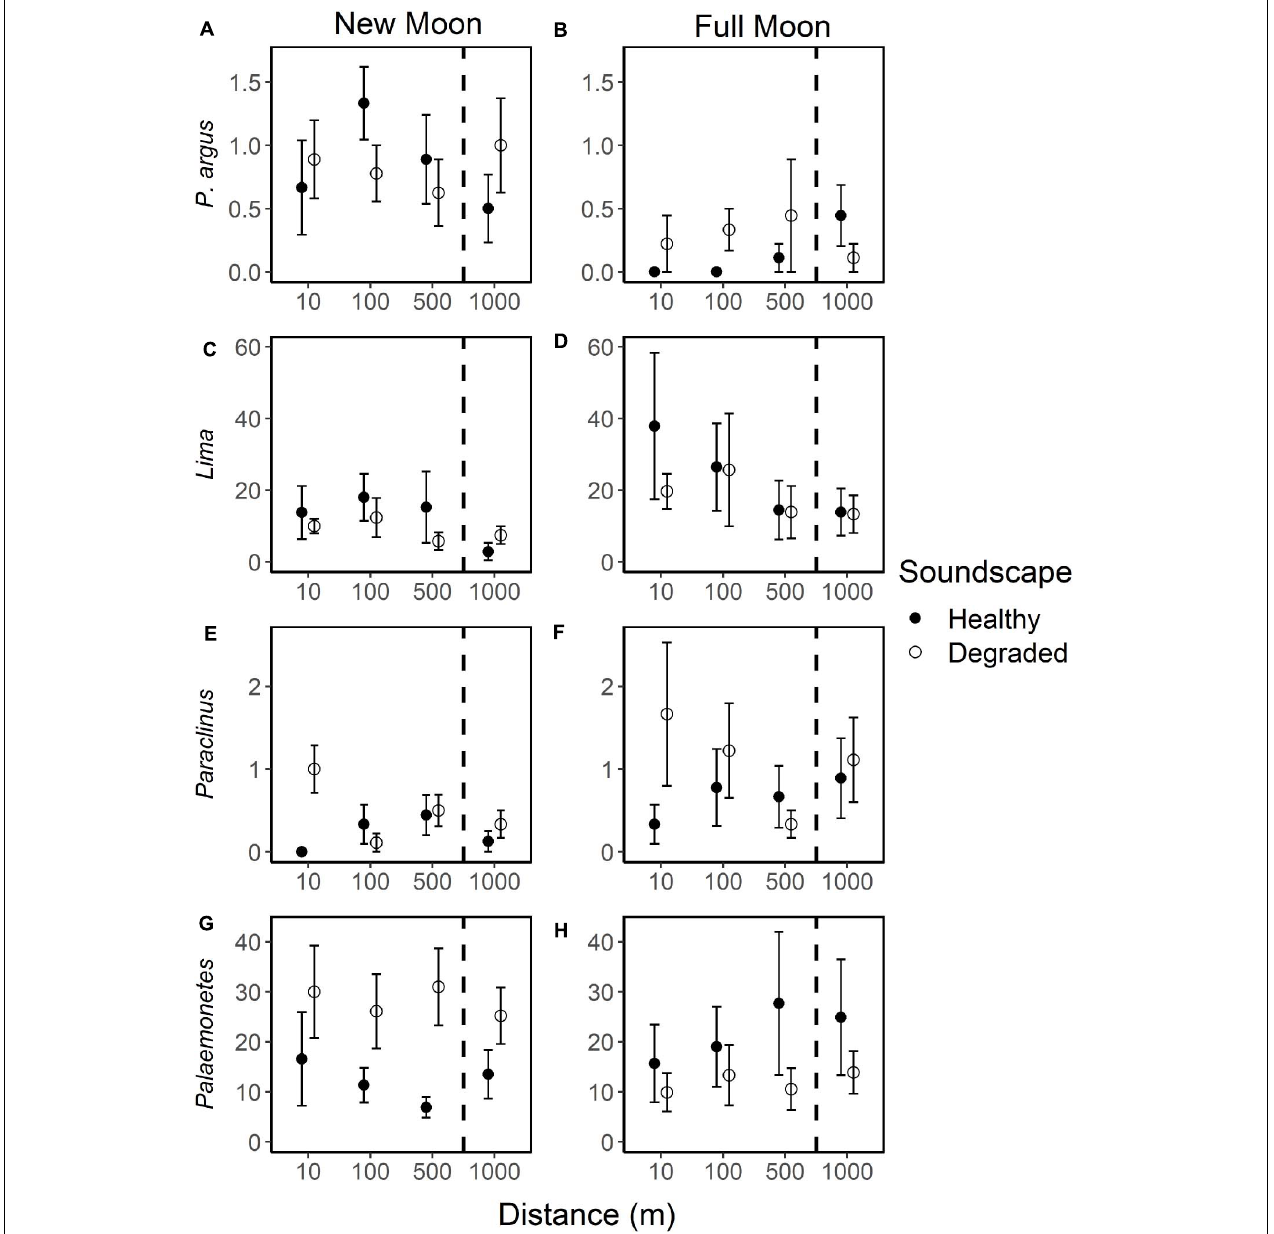
FIGURE 7 | Mean individuals of selected taxa per collector during new and full moon phases on collectors exposed to broadcasted healthy (closed circle) and degraded (open circle) soundscapes at 10, 100, 500, and 1,000 m from the underwater speaker. All error bars are standard error. Selected species are shown: spiny lobster [ Panulirus argus (A,B) ], clam [ Lima (C,D) ] with two outliers at 1,000 m removed, blenny [ Paraclinus (E,F) ], shrimp [ Palaemonetes (G,H) ]. Dashed lines indicate collectors that lie outside the detectable sound range (1,000